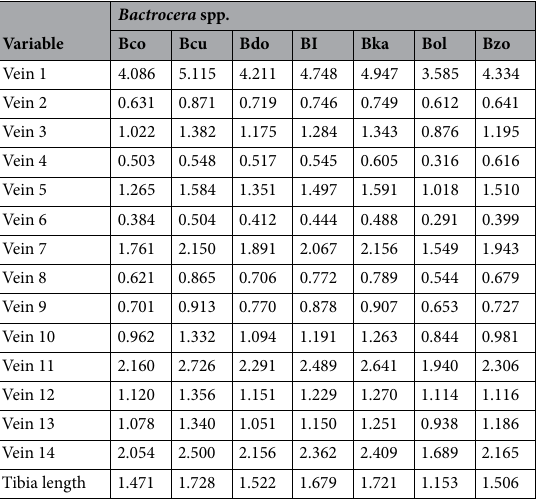
Table 5. Mean measurements of wing vein distances and tibia length (mm) of fruit fly ( Bactrocera spp.) specimen collected from African countries and Asia. Bco— B. Correcta (n = 18), Bcu— B. cucurbitae (n = 31), Bdo— B. dorsalis (n = 28), BI— B. invadens (n = 940), Bka— B. kandiensis (n = 28), Bol— B. oleae (n = 28), Bzo— B. zonata (n =